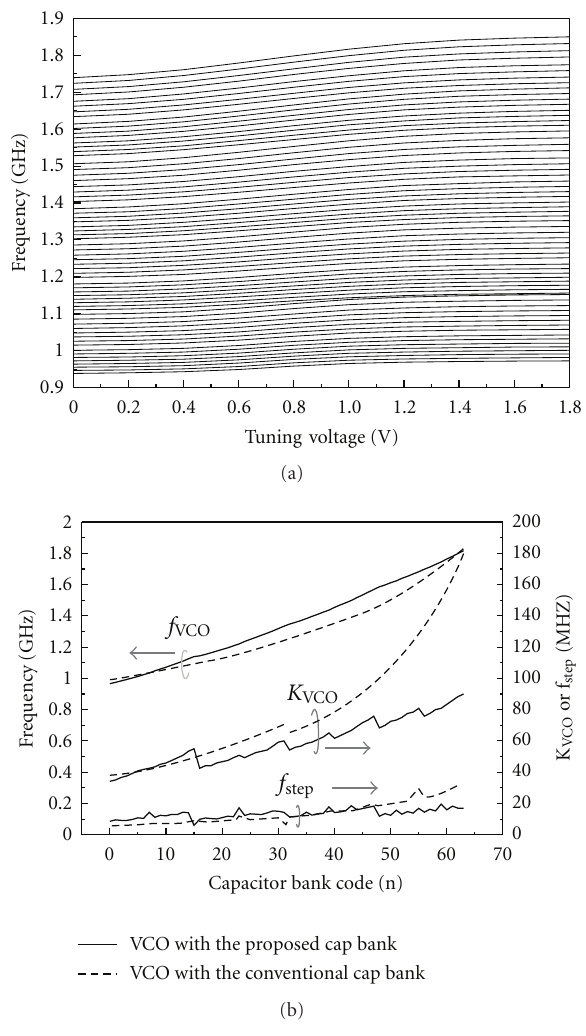
Figure 18: Measured VCO tuning characteristics. (a) Frequency tuning curves. (b) VCO output frequency, K VCO , and f step over the 64 tuning